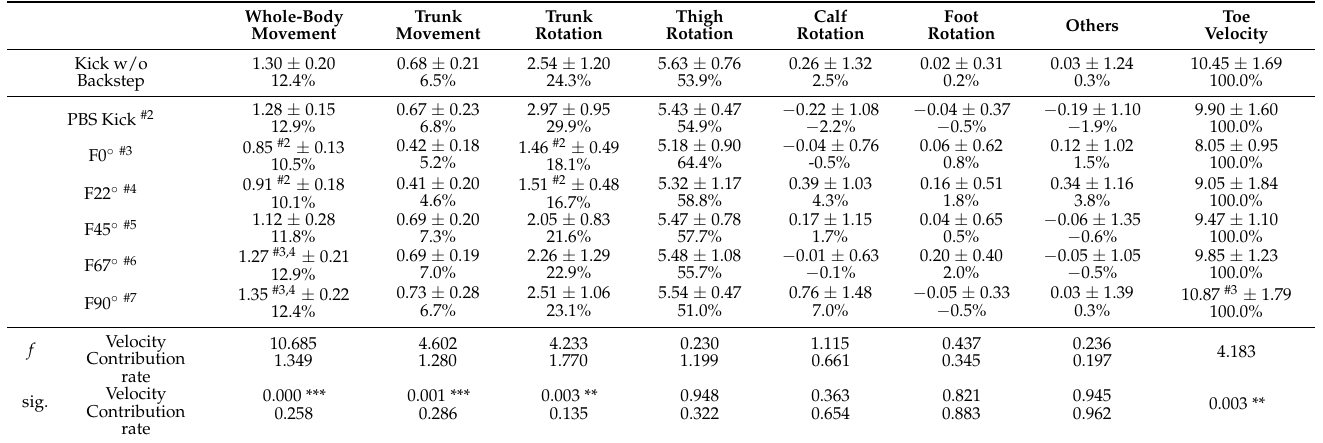
Table 1. The contributions of the roundhouse kick with angle-change types of footwork in MKF event. Units: m/s.